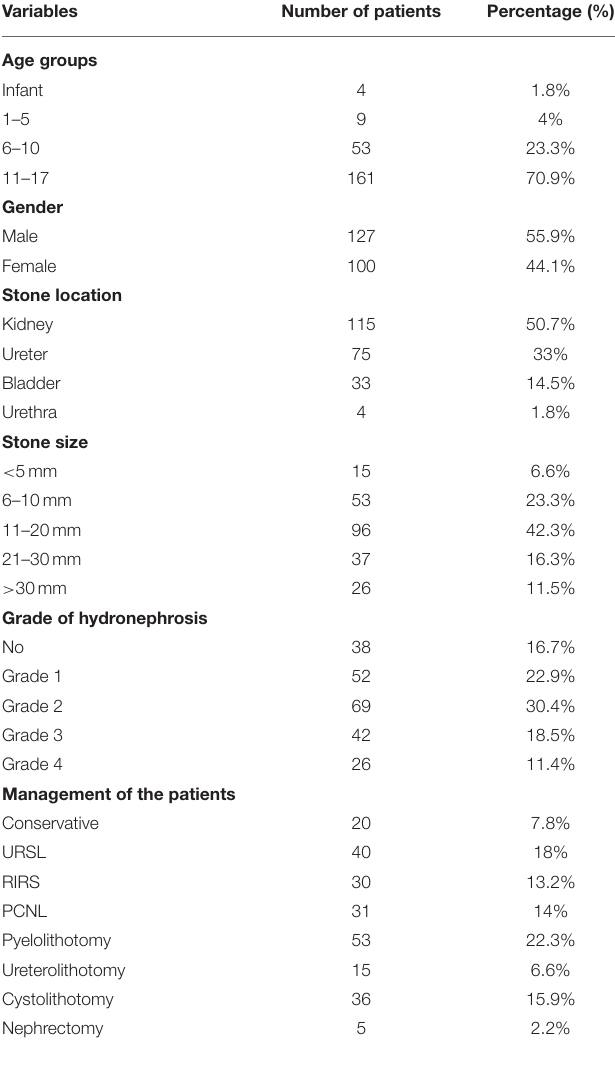
TABLE 1 | Sociodemographic, radiological, and treatment data of the